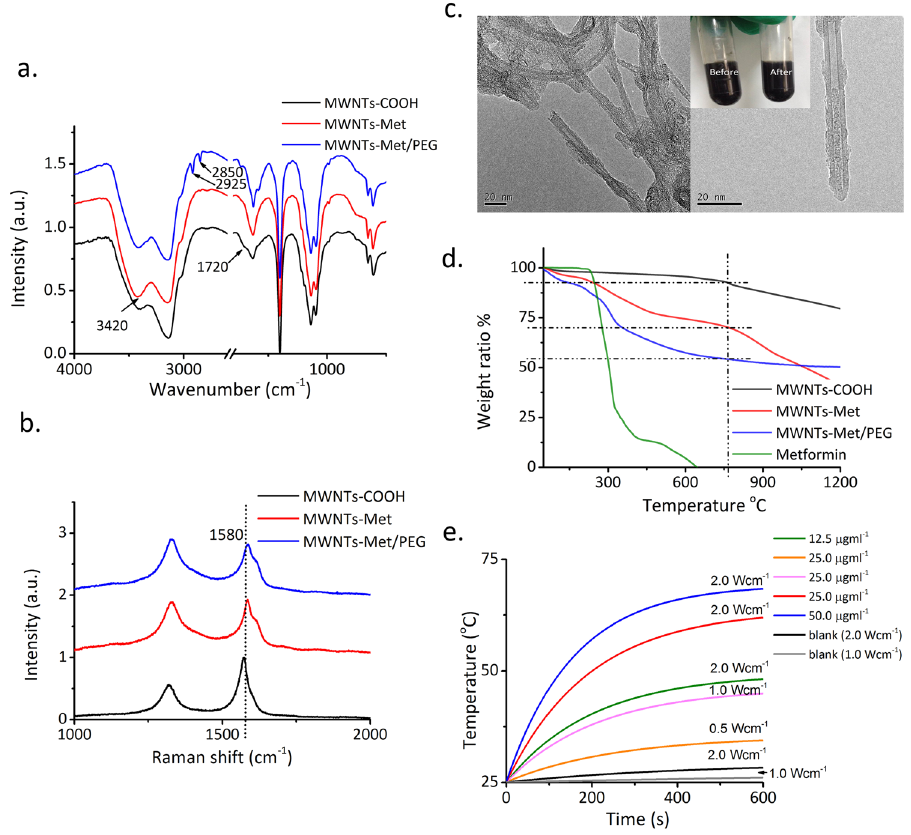
Figure 2. ( a ) FTIR spectra of MWNTs-COOH, MWNTs-Met and MWNTs-Met/PEG. ( b ) The Raman spectra of MWNTs-COOH, MWNTs-Met and MWNTs-Met/PEG. ( c ) TEM images of MWNTs-Met/PEG. The inset is the photographs of MWNTs-Met/PEG before and after 3000 rpm centrifugations. ( d ) The TGA curves of metformin, MWNTs-COOH, MWNTs-Met and MWNTs-Met/PEG. ( e ) Photothermal response of MWNTs- Met/PEG under various concentration ( µ g·mL − 1 ) and NIR power density. The photothermal response is concentration and power dependent. The photothermal response curves were fitted with exponential function and R 2 > 0.99.